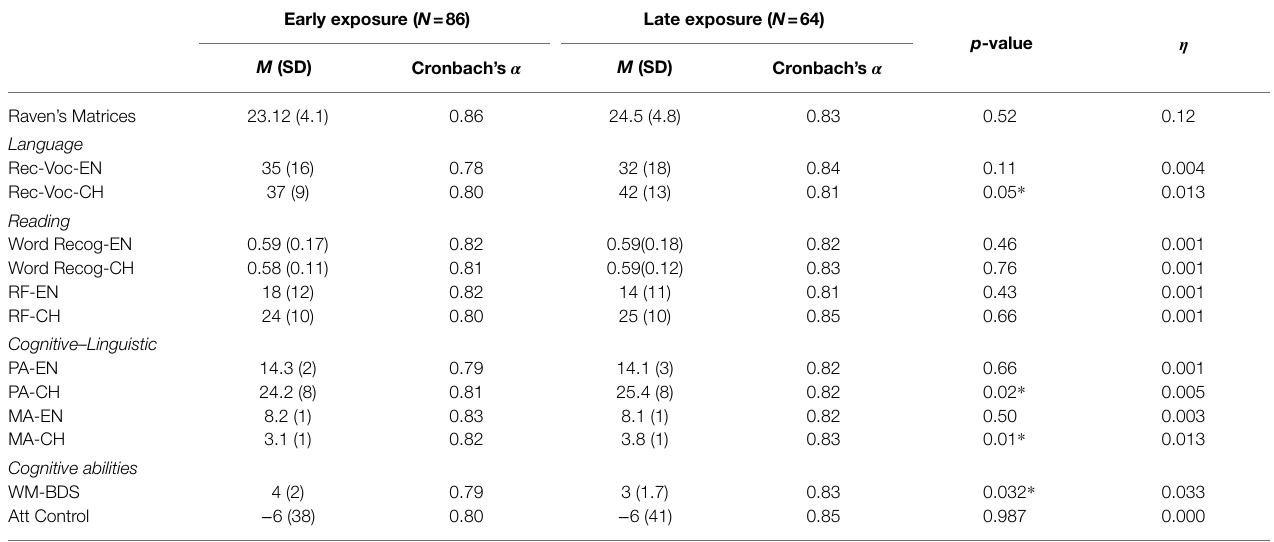
TABLE 2 | Descriptive statistics by tasks for grade 3: early vs. late exposure to English.